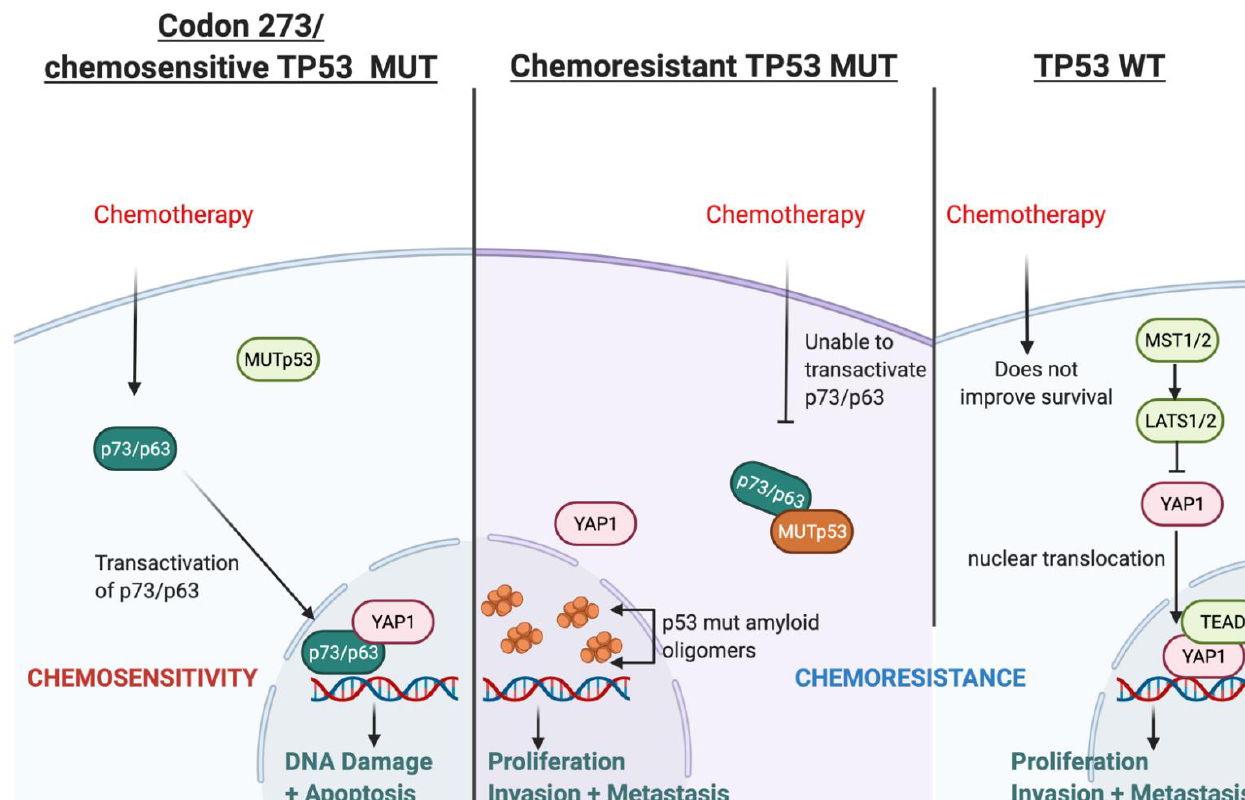
Figure 10. Illustration of the hypothesised mechanism through which TP53 mutation type determines chemosensitivity in astrocytoma involving transactivated p63/p73 and YAP1 .